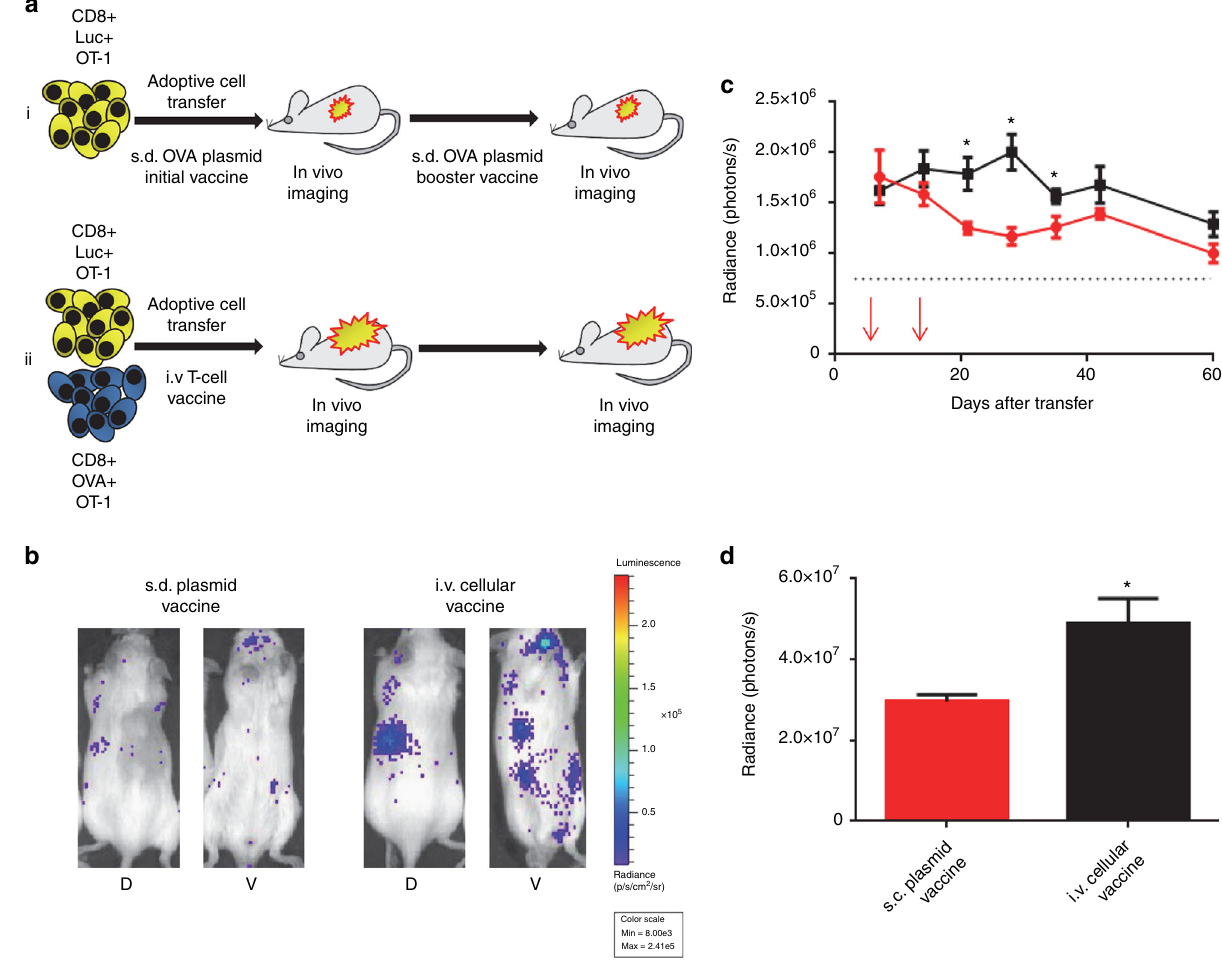
Fig. 3 A comparison of vaccination approaches for augmenting T-cell engraftment. Vaccination approaches for augmenting lymphocyte engraftment were evaluated by infusing 1 × 10 7 CD8 + T cells genome-modi fi ed with the pT-ef fl uc-thy1.1 transposon. a Schematic representation of experiments comparing (i) subdermal vaccination (s.d.) and (ii) intravenous (i.v.) vaccination; yellow cells indicate T cells transfected with pT-ef fl uc-thy1.1 and pCMV-m7pB, blue cells indicate vaccine T cells transfected with pTSB-CAG-OVA and pCMV-SB100X. b Representative bioluminescent images taken 21 days after iv transfer of 1 × 10 7 genome-modi fi ed CD8 + T cells comparing the engraftment facilitated by a subdermal plasmid vaccine regimen (left panels) or an i.v. OT-1 T-cell vaccine (D, dorsal; V, ventral) ( N = 5). c Plot showing total (dorsal + ventral) luciferase signals measured in mice that received either two subdermal plasmid vaccines at days 1 and 10 after transfer (red arrows), or a single i.v. OT-1 T-cell vaccine concomitantly during autologous transfer. Dashed line indicates mean luminescence signal observed in mice injected with saline without d -luciferin ( N = 5 ± SEM, * p < 0.05 using Student ’ s T -test comparing at given time points). d Plot showing area under the curve for the sum total of the measurements presented in c ( N = 5 ± SEM, * p < 0.05 using Student ’ s T